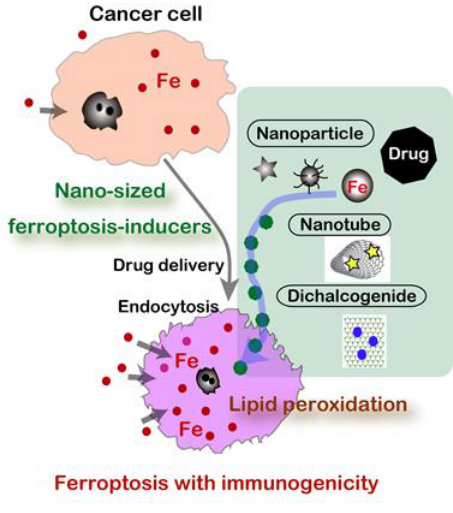
Figure 5. Nanomaterials as novel ferroptosis inducers for cancer cells.